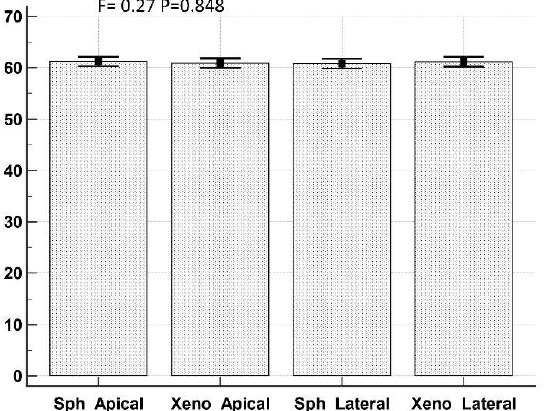
Figure 12. ANOVA test with Bonferroni correction of diameter values of apical-secreted and baso- lateral-secreted exosomes in MTSs and xenografts. Sph Apical: exosome diameter in spheroid apical secretion; Sph Lateral: exosome diameter in spheroid basolateral secretion; Xeno Apical: exosome diameter in xenograft apical secretion; Xeno Lateral: exosome diameter in xenograft basolateral se- cretion.